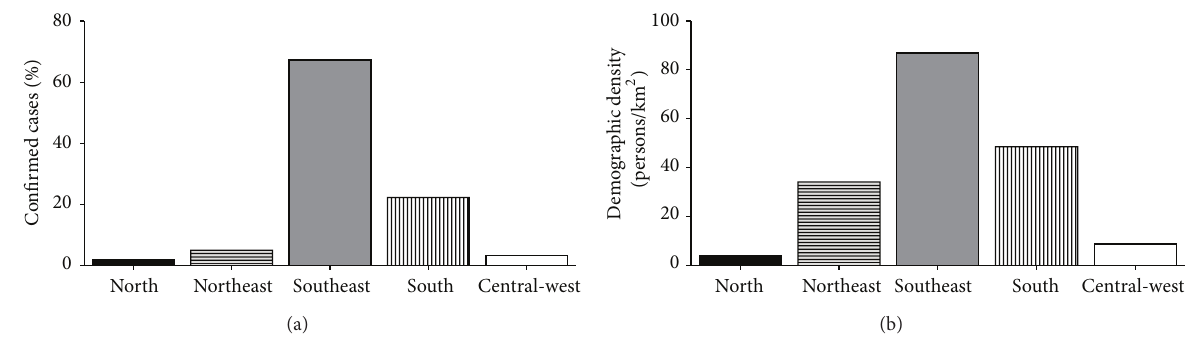
Figure 2: Brazilian regions: (a) distribution of hepatitis C confirmed cases according to the Ministry of Health [5] and (b) population density according to Brazilian Institute of Geography and Statistics [6].